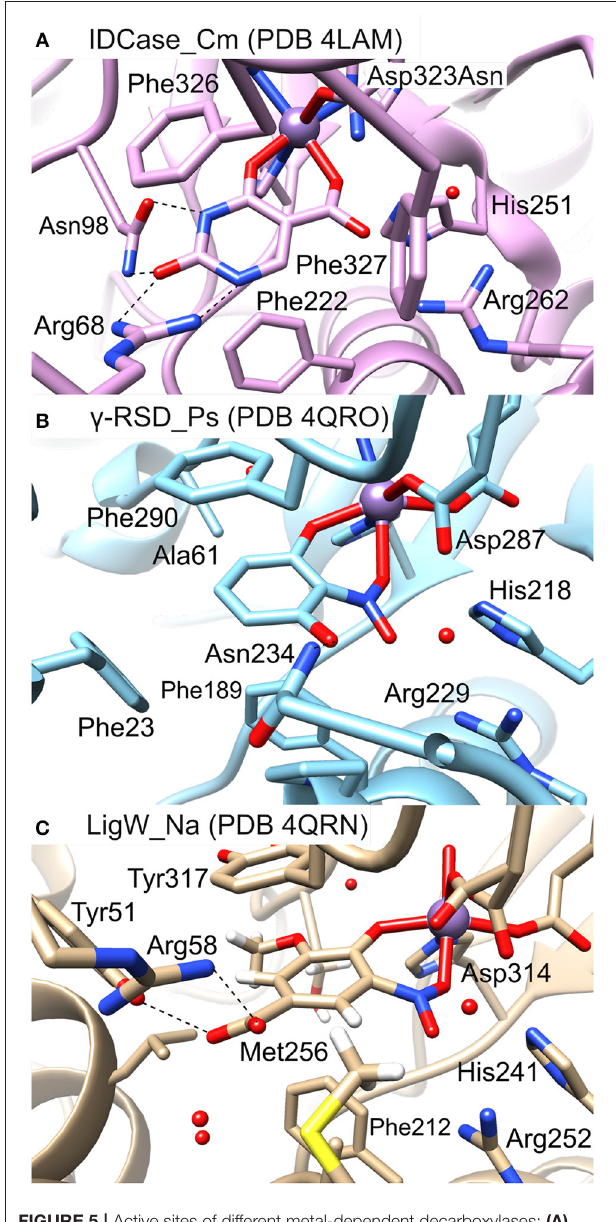
FIGURE 5 | Active sites of different metal-dependent decarboxylases: (A) IDCase_Cm, (B) γ -RSD_Ps, and (C)